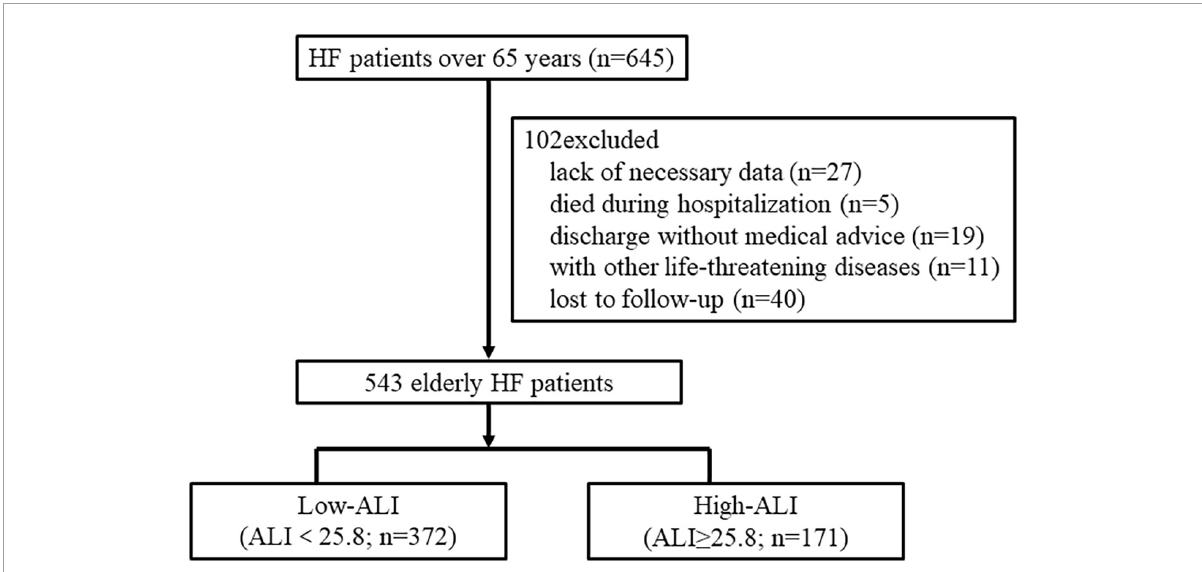
FIGURE1 Flow chart for the study. The patients were divided into two groups based on the cutoff value of ALI for predicting all-cause mortality at 2 years. HF, heart failure; ALI, advanced lung cancer inflammation index.